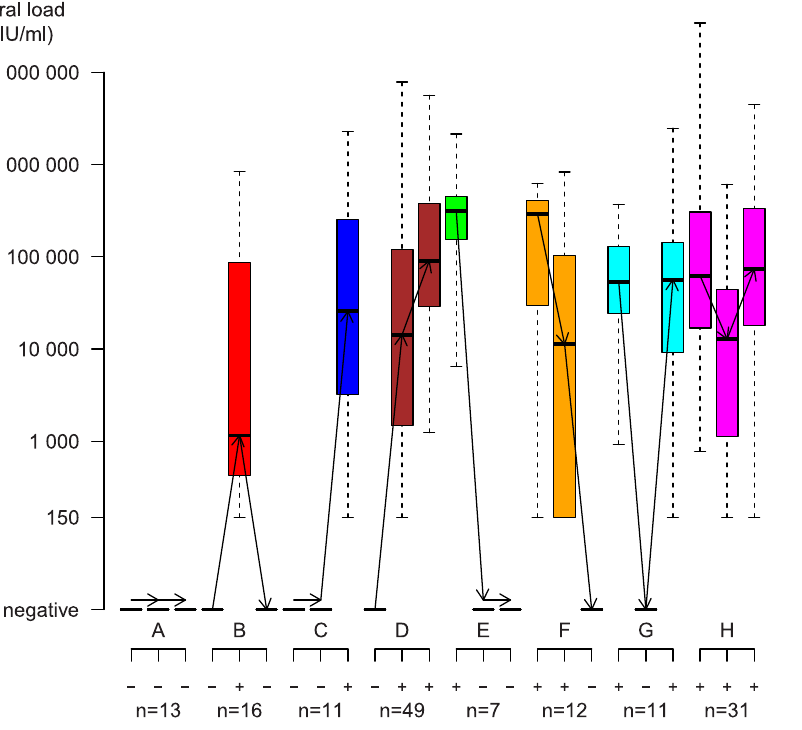
Figure 1. Viral kinetics in the eight different groups (A through H) observed. Groups are defined as described in Materials and Methods, depending on if viremia was detectable or not and indicated by + or 2 . Viral loads, presented as boxplot diagrams, in different colour for each group (A=black, B=red, C=dark blue, D=brown, E=green, F=orange, G=cyan/light blue, H=magenta) show median, 25% and 75% interquartile range and outliers. For each patient group, the first time point/column represents the last anti-HCV negative sample, the second first anti-HCV positive and the third the one year follow-up. For each group A-H the number of subjects is shown. Viral loads are presented in a log 10 scale, and the samples that were RNA positive but below quantifiable as 149 IU/mL, to distinguish from samples where RNA was not detected, which were set one log 10 lower at 15 IU/mL.